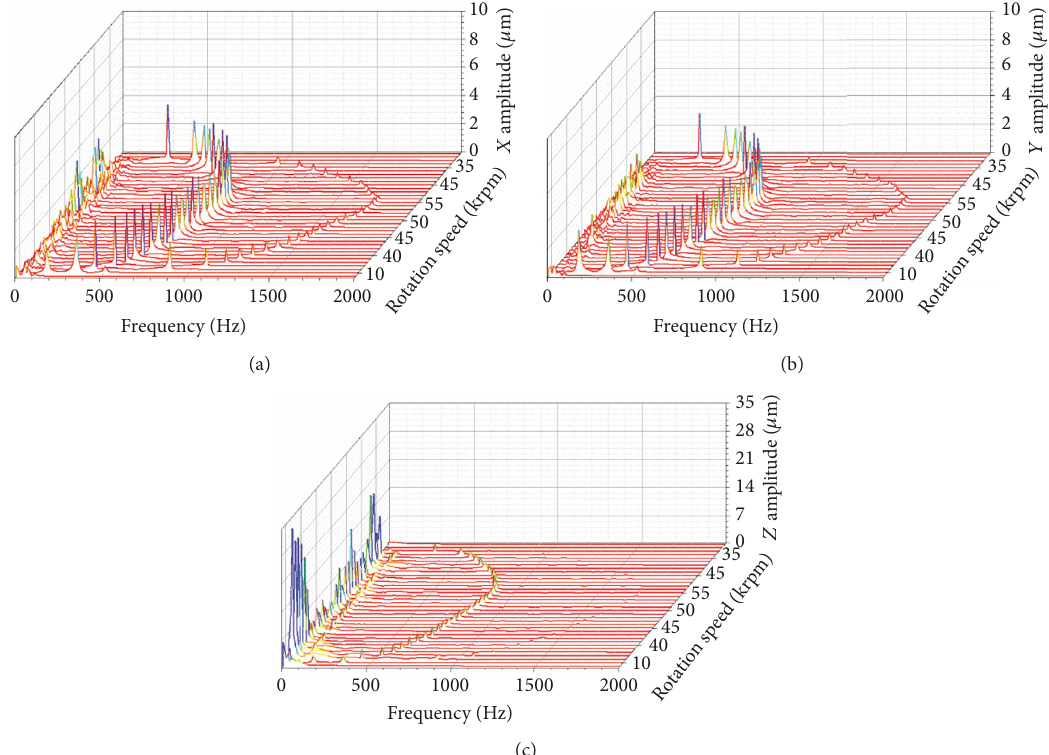
Figure 12: Spectrum cascade plot of the high speed rotor in the speed-up and coast-down process: (a) 𝑋 direction; (b) 𝑌 direction; (c) 𝑍